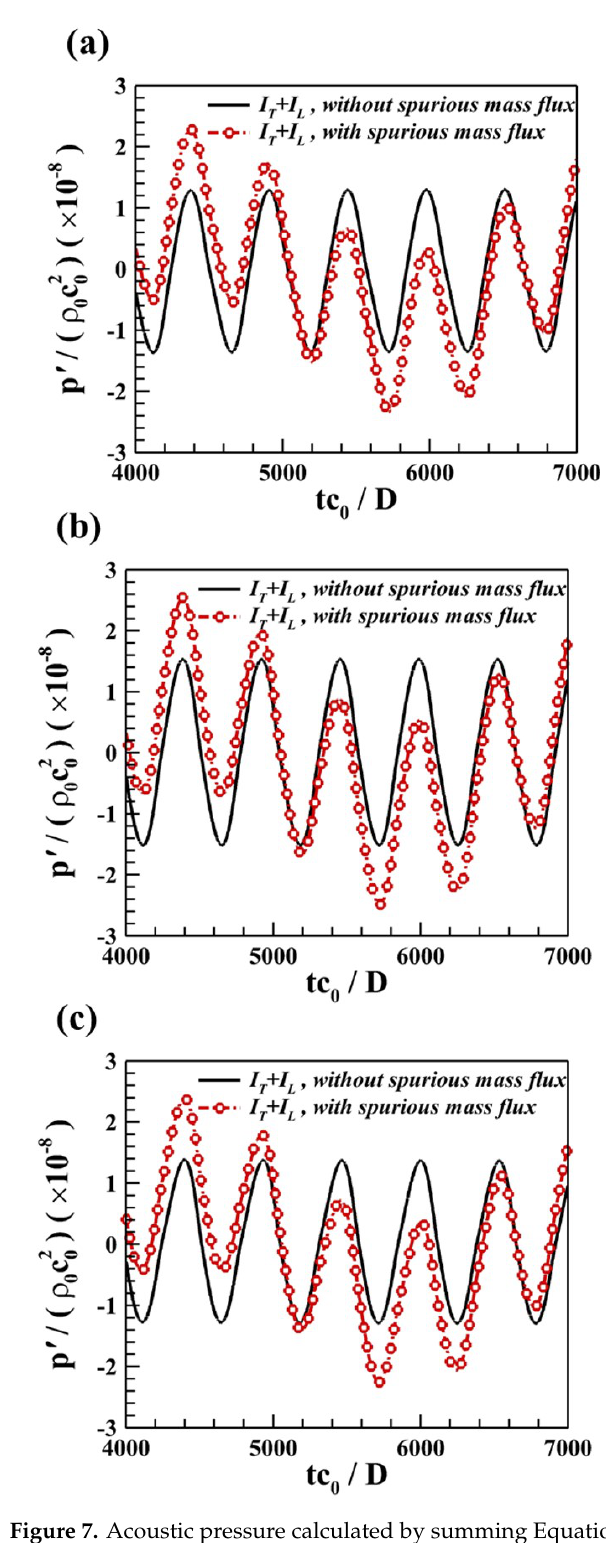
(cid:0) (cid:0) π (cid:1) (cid:0) π (cid:1)(cid:1) cos ,sin , ( b ) 1000 D 3 3